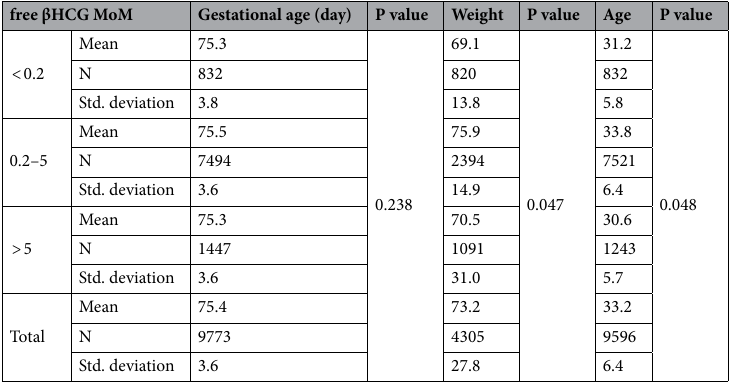
Table 1. Mean of gestational age, weight and maternal age in different groups of patients based on the levels of free βHCG MoM.